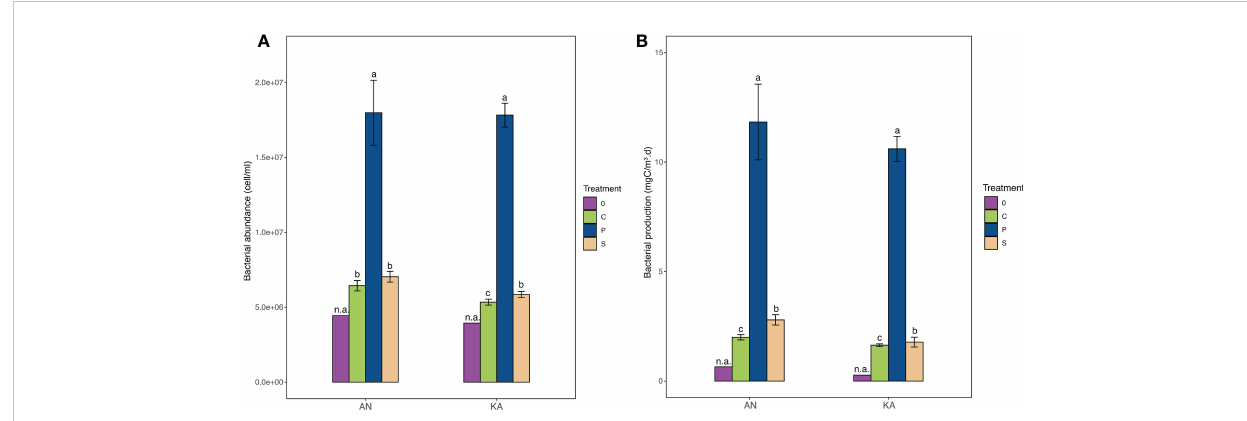
FIGURE 2 Bacterial abundance (A) and bacterial production (B) in different treatments measured in Kalvarsskatan (KA) and Ängerån (AN) bay at the start (and the end (day 2) of the experiment. The colours in the graph represent different treatments, with purple representing day 0, green representing control, blue representing plankton extract treatment, and brown representing soil extract treatment, day 2. Values are means of 3 replicates ± standard deviation. 0: day 0 (before DOM amendments). Error bars represent the standard deviation. The letter s “ a ” “ b ” and “ c ” placed above each bar indicate signi fi cant differences ( a = 0.05) between the treatments (excluding day 0), as determined by Kruskal – Wallis tests.